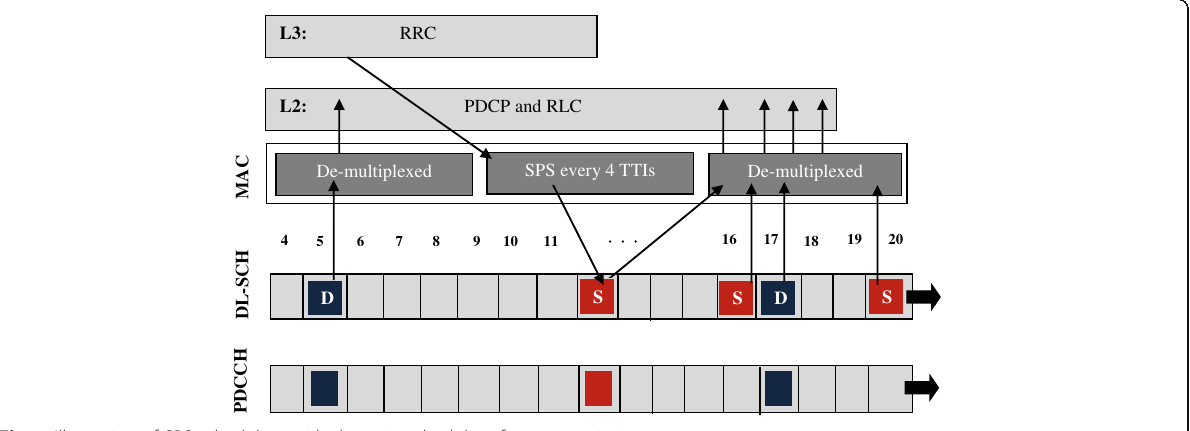
Fig. 5 Illustration of SPS scheduling with dynamic scheduling for